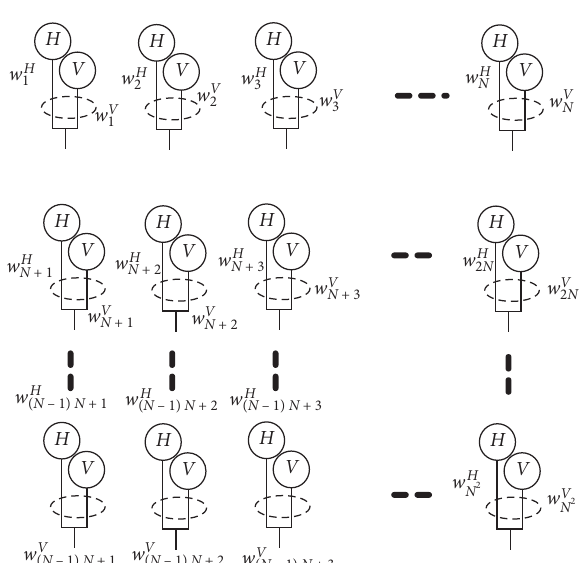
Figure 3: Dual-polarized smart antenna